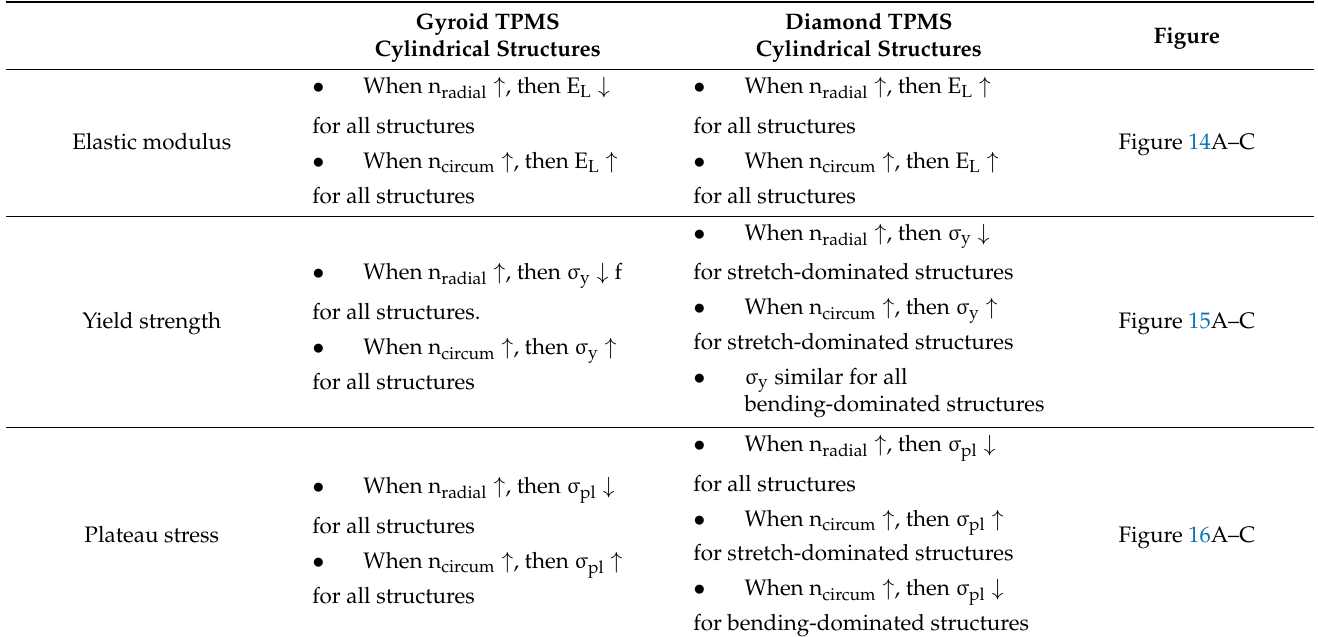
Table 6. Relationships between design parameters and mechanical properties for Gyroid [52] and Diamond TPMS cylindrical structures. Where: ↑ increase. ↓ decrease. Gyroid TPMS Diamond TPMS Cylindrical Structures Cylindrical